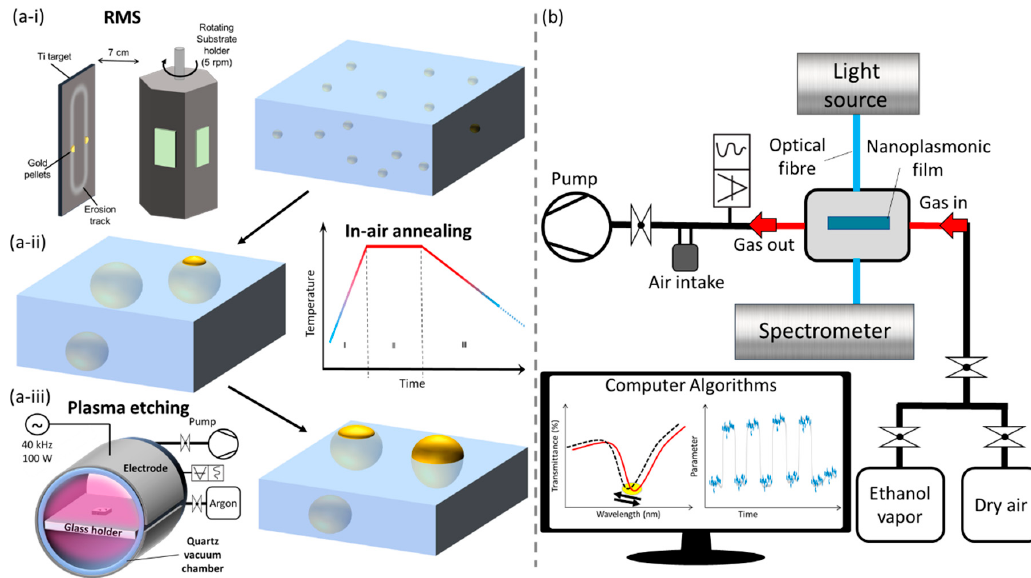
Figure 1. ( a ) Simplified production methods for the plasmonic thin-film sensors in three steps, ( a-i ) Reactive Magnetron Sputtering (RMS) showing the target and the sample holder geometry inside the vacuum chamber), ( a-ii ) in-air annealing process in three phases (I—heating ramp of 5 ◦ C / min, II—plateau at 400 ◦ C for 5 h, and III—free cooling), and ( a-iii ) argon plasma etching process in a Diener Zepto vacuum chamber. ( b ) Simplified schematics of the optical Transmittance–Localized Surface Plasmon Resonance (T-LSPR) sensing system.